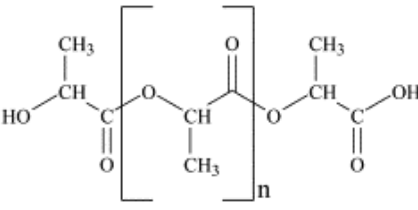
Figure 2. Chemical structure of the repeating unit of PLA.